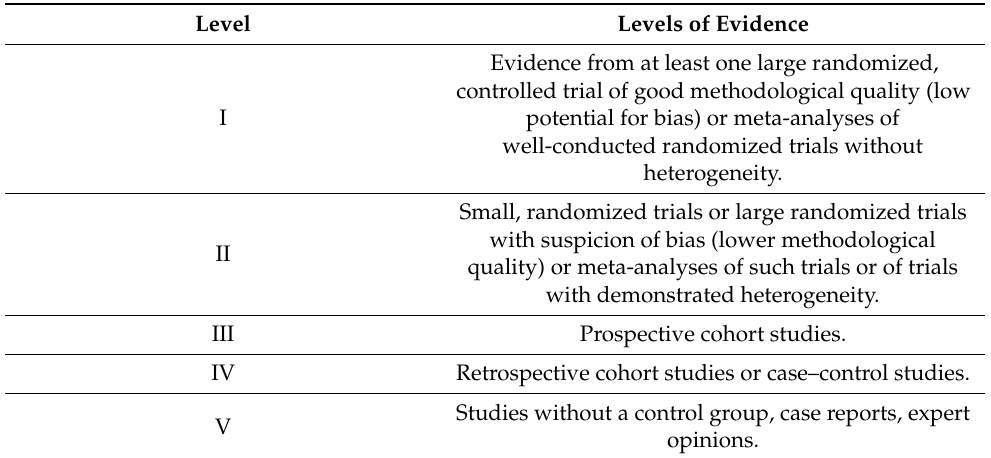
Table 3. Levels of